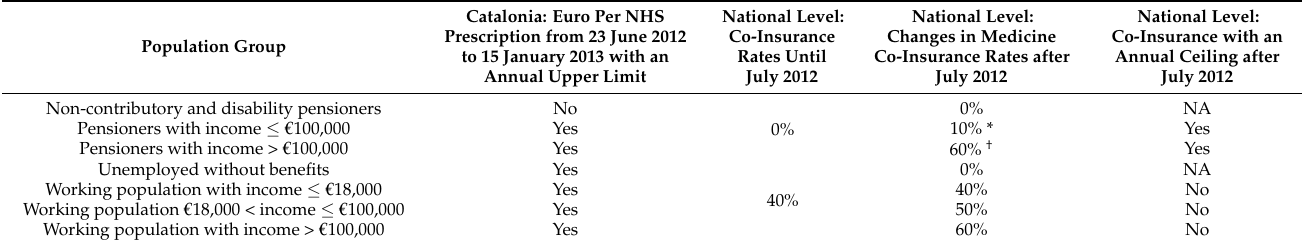
Table 1. National and Catalan cost-sharing schemes for medicines in Spain. Comparison before and after 2012 national reforms.